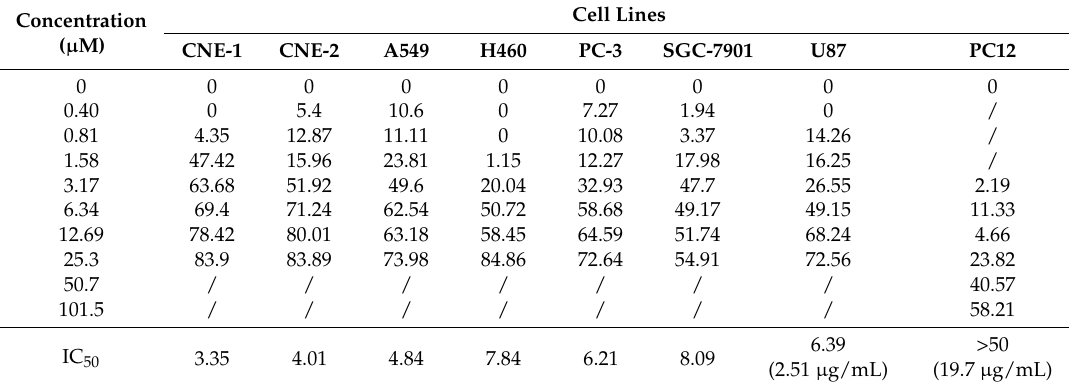
Table 2. Cytotoxic activities of compound 1 .